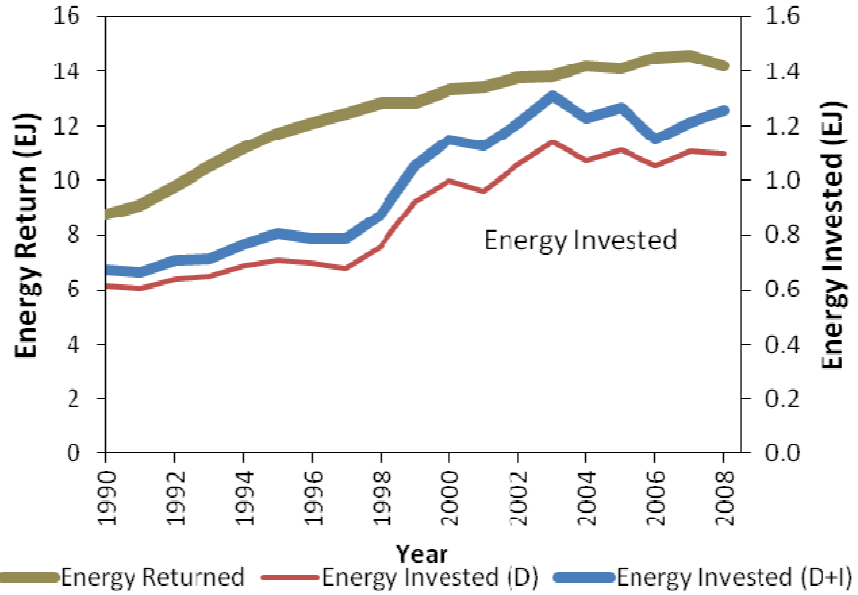
Figure 2. Energy return and energy investment: total oil and